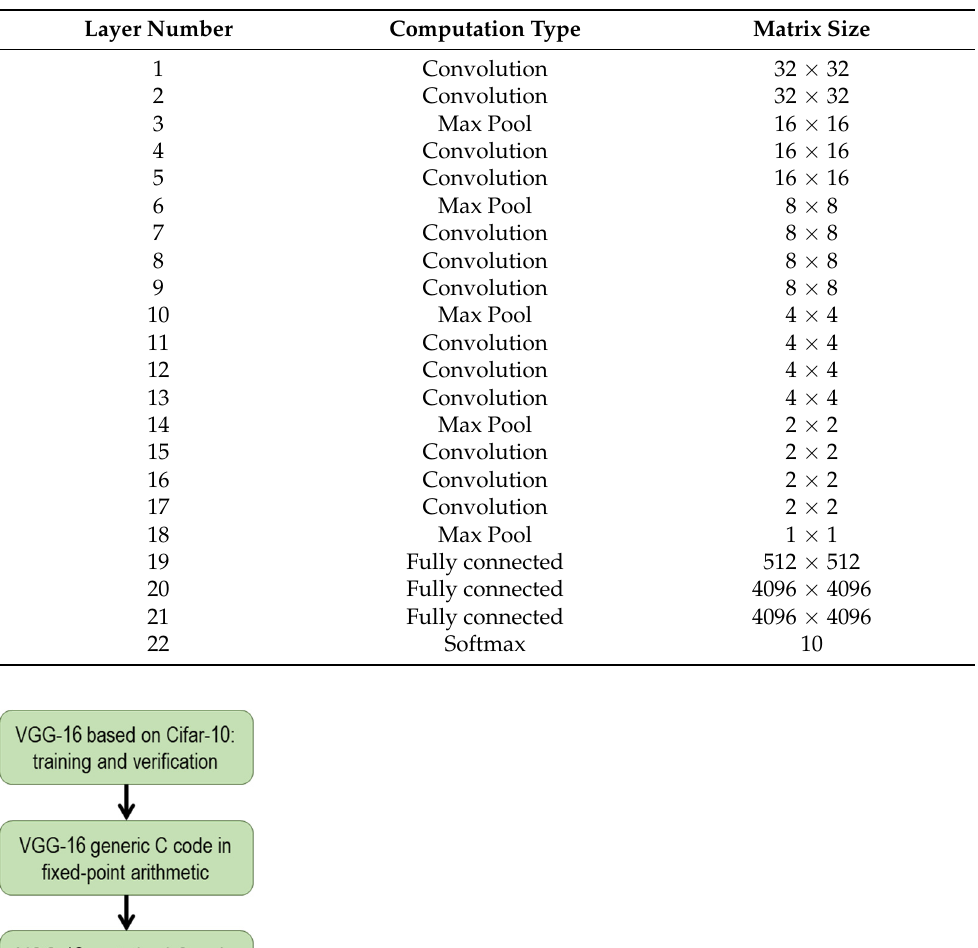
Table 3. Cifar-10 VGG-16 inference layers.